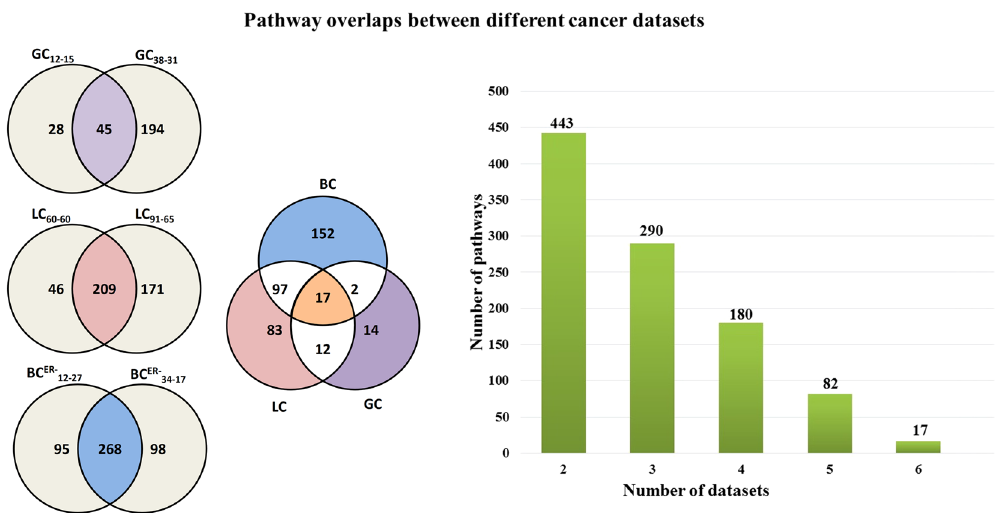
Figure 2. Overlaps of significant pathways detected for the three cancer types. The bar plot shows the number of significant pathways ( y -axis) shared by at least two, three, four, five and six datasets ( x -axis) for BC, LC and